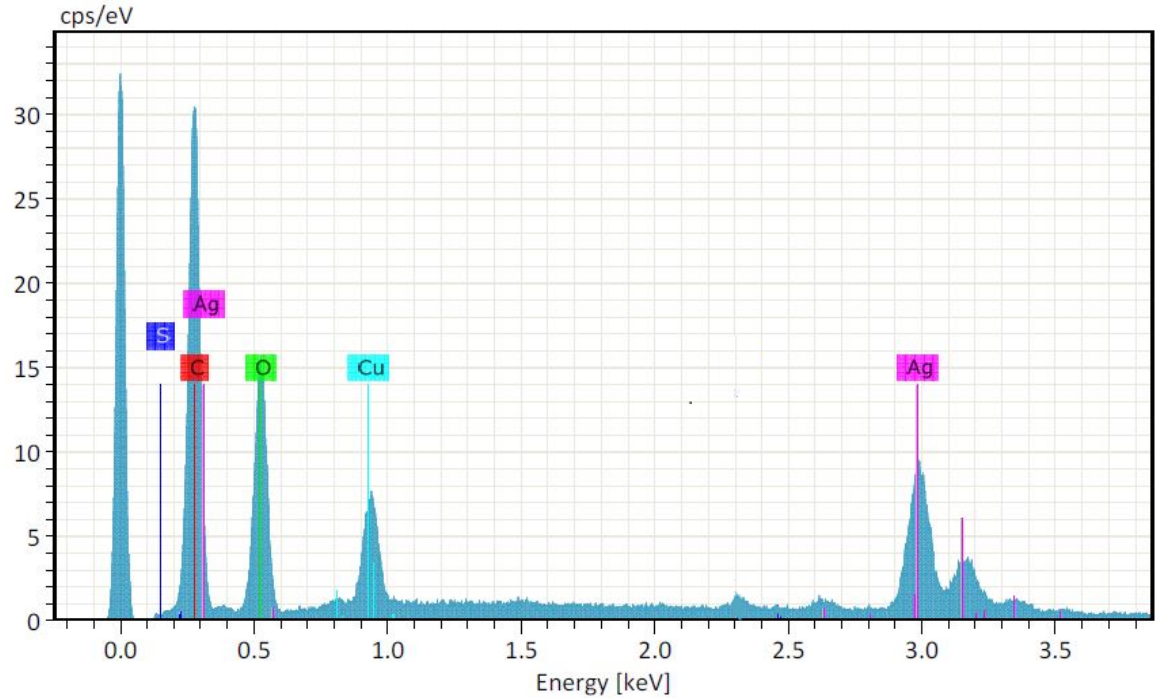
Figure 3. Elemental composition of Ag-CuO NC depicted in EDX spectrum.